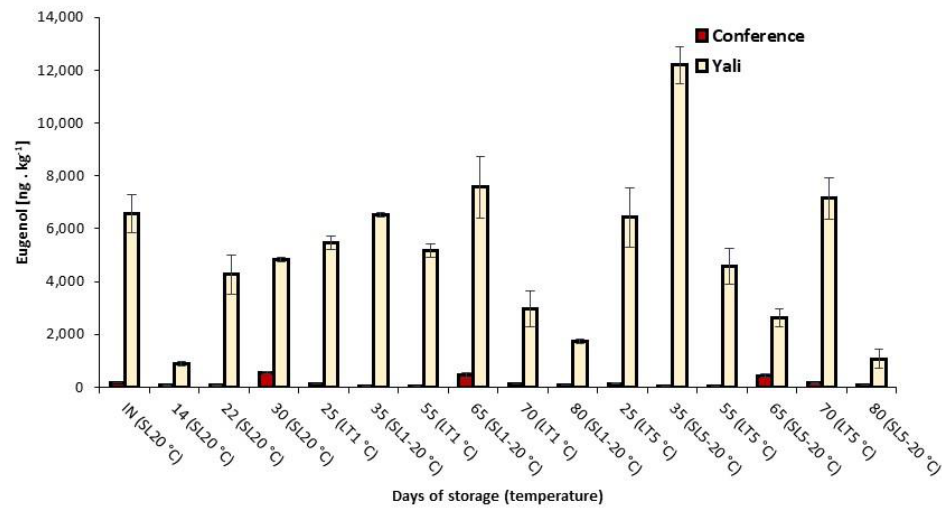
Figure 2. Concentration changes of eugenol in ‘Conference’ and ‘Yali’ pear cultivars depending on time and storage regimes. (SL20 °C — shelf-life at 20 °C; LT — low storage at 1 or 5 °C; SL1-20 °C, SL5-20 °C — shelf-life at 20 °C after storage at 1 or 5 °C).